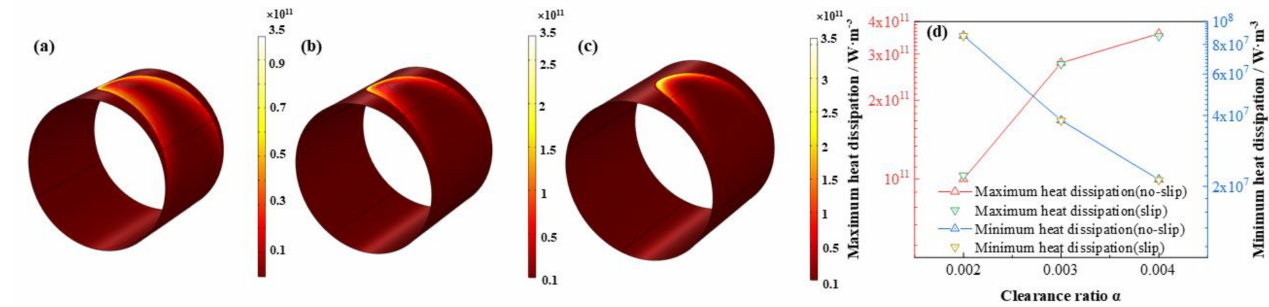
Figure 26. Comparison of the heat dissipation distribution under different clearance ratios. ( a ) α = 0.002; ( b ) α = 0.003; ( c ) α = 0.004; ( d ) maximum/minimum heat